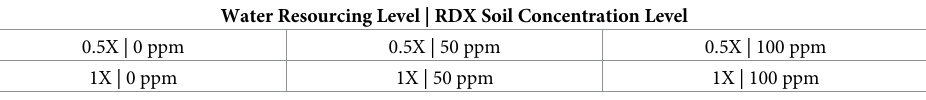
Table 2. Water-resource and RDX soil concentration treatment classes employed in greenhouse